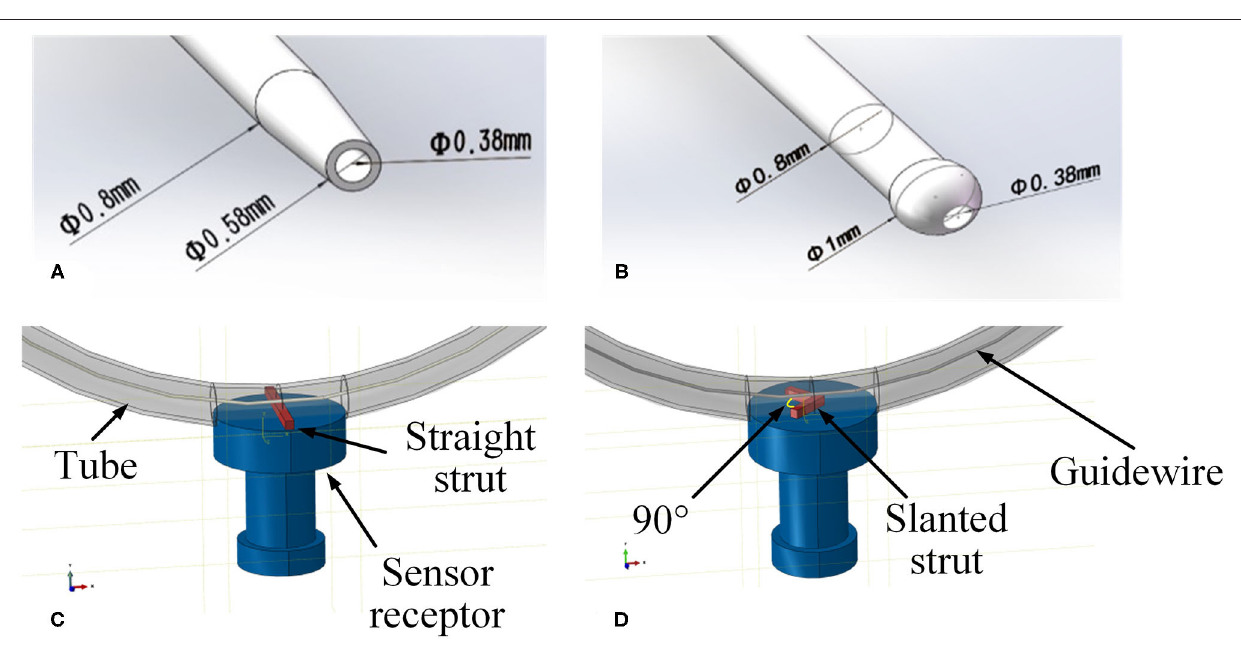
Frontiers in Physiology |